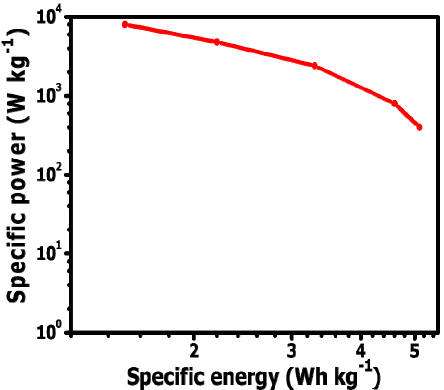
Figure 7. Ragone plot of the activated BN-CSs symmetric cell.